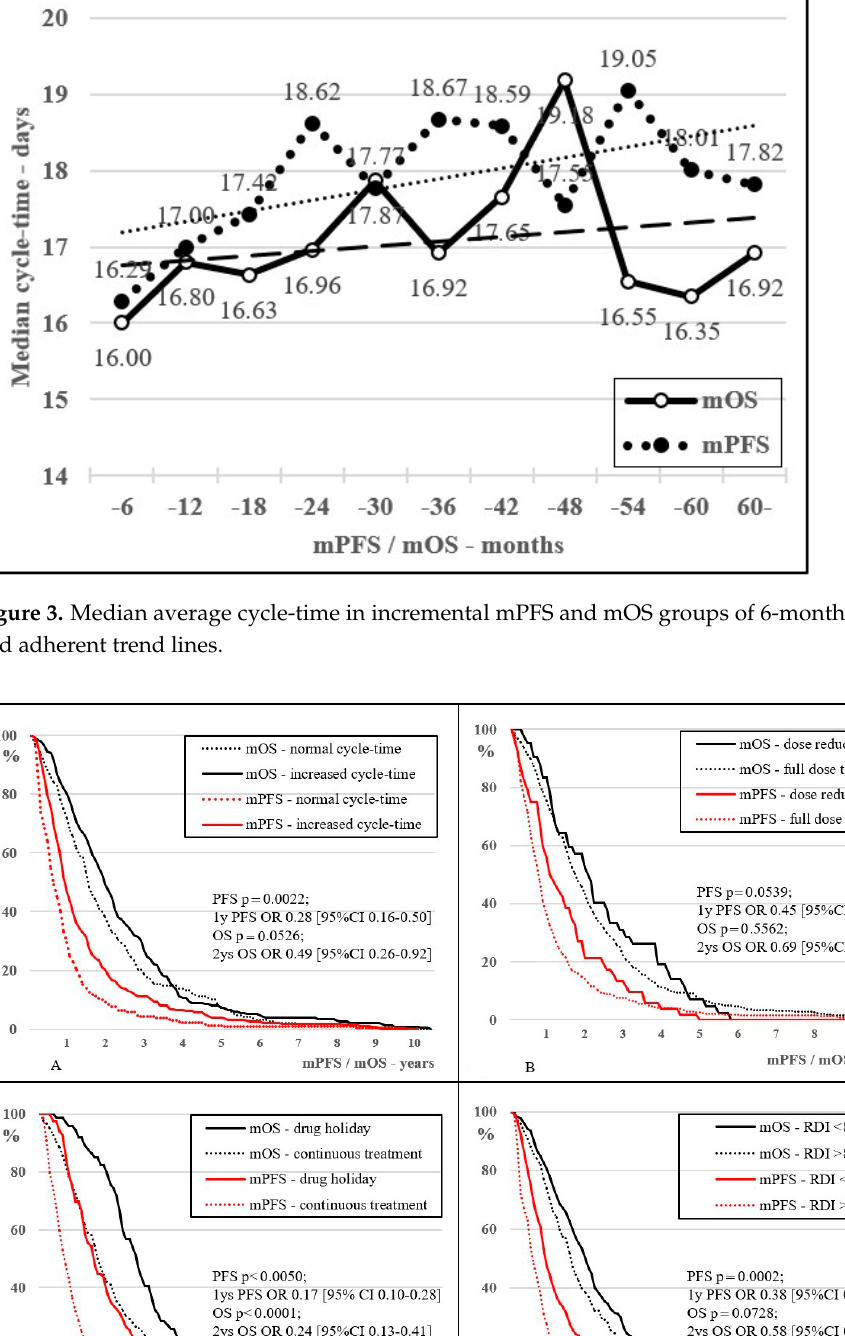
Figure 2. ( A ) mToT , ( B ) mPFS , and ( C ) mOS changes and trend lines according to the rate of devi- ation of cycle-time (incremental cycle-time groups of 20% relative to normal) by chemotherapy sub- groups and trend lines.